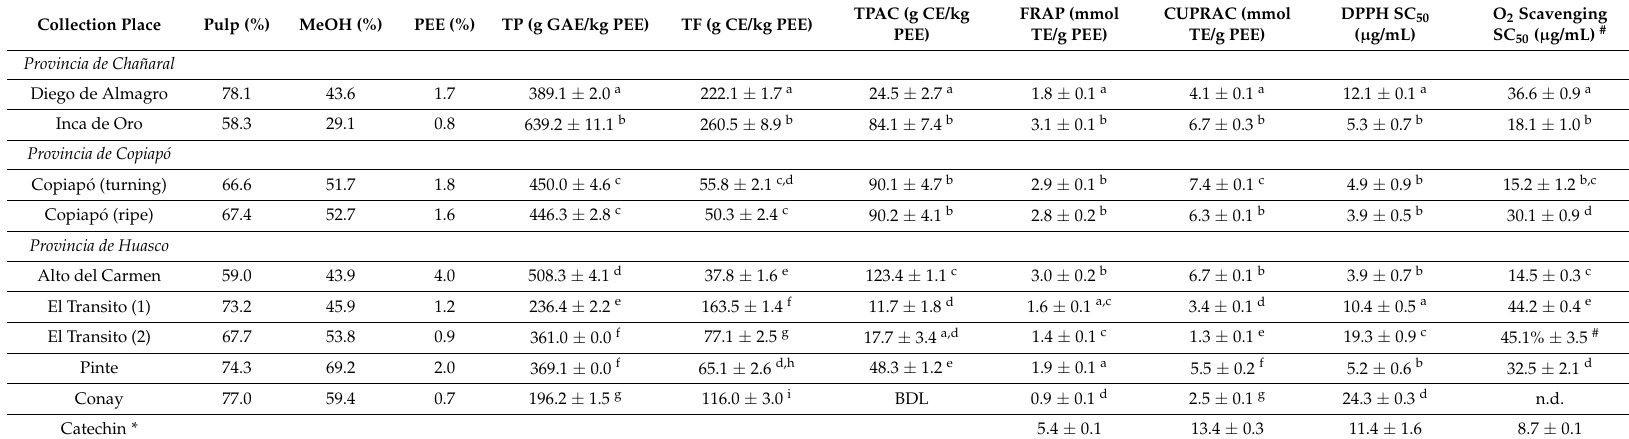
Table 1. Pulp percent, yields of methanol extract (MeOH) and phenolic-enriched extract (PEE), total phenolic (TP), total flavonoid (TF), total proanthocyanidin (TPAC) content and antioxidant activity of G. decorticans fruit